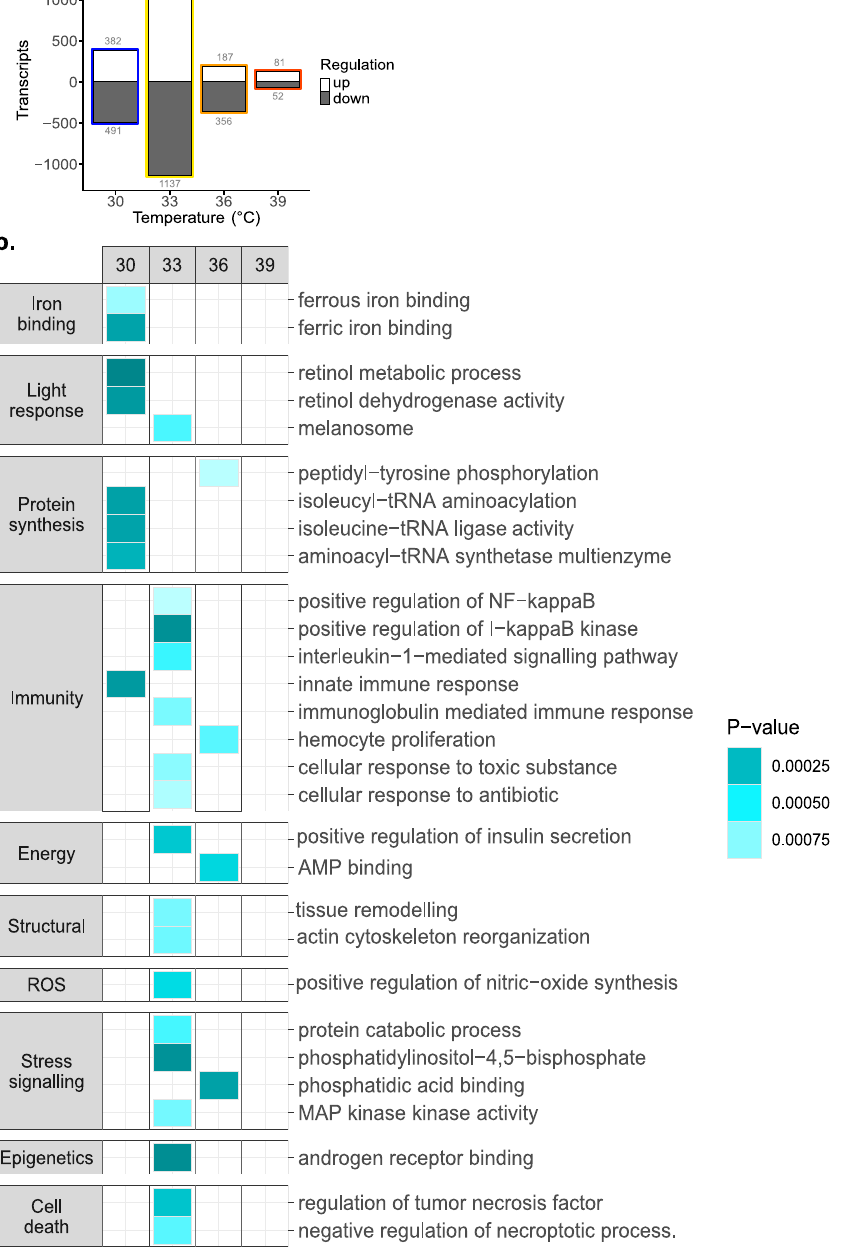
Figure 3. Deoxygenation-specific stress responses may influence coral bleaching susceptibility. ( a) Number of differentially expressed transcripts that were up- (white) and down- (grey) regulated. At each temperature (30 °C, 33 °C, 36 °C, and 39 °C) deoxygenation and normoxic conditions are compared after 6 h of the thermal profile (time point 1, Fig. 1a). (b) Heat map of gene ontology (GO) enriched terms of differentially expressed transcripts (P-value < 0.001). Comparisons (top panel) include heat & hypoxia (Hd) versus heat only (H0) within temperatures (30 °C, 33 °C, 36 °C, and 39 °C). Categories (left) manually curated for the GO terms (right). The colour gradient indicates P values, where darker turquoise is indicative of greater significance. White space indicates no GO